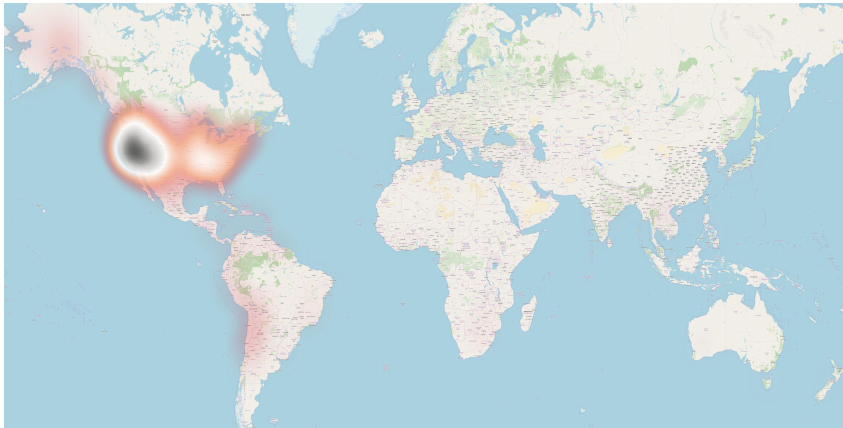
Figure 9. Point cluster analysis with clusters in red triangles and points in brown small circles.